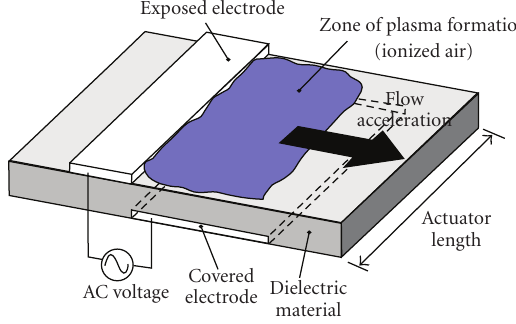
Figure 1: SDBD plasma